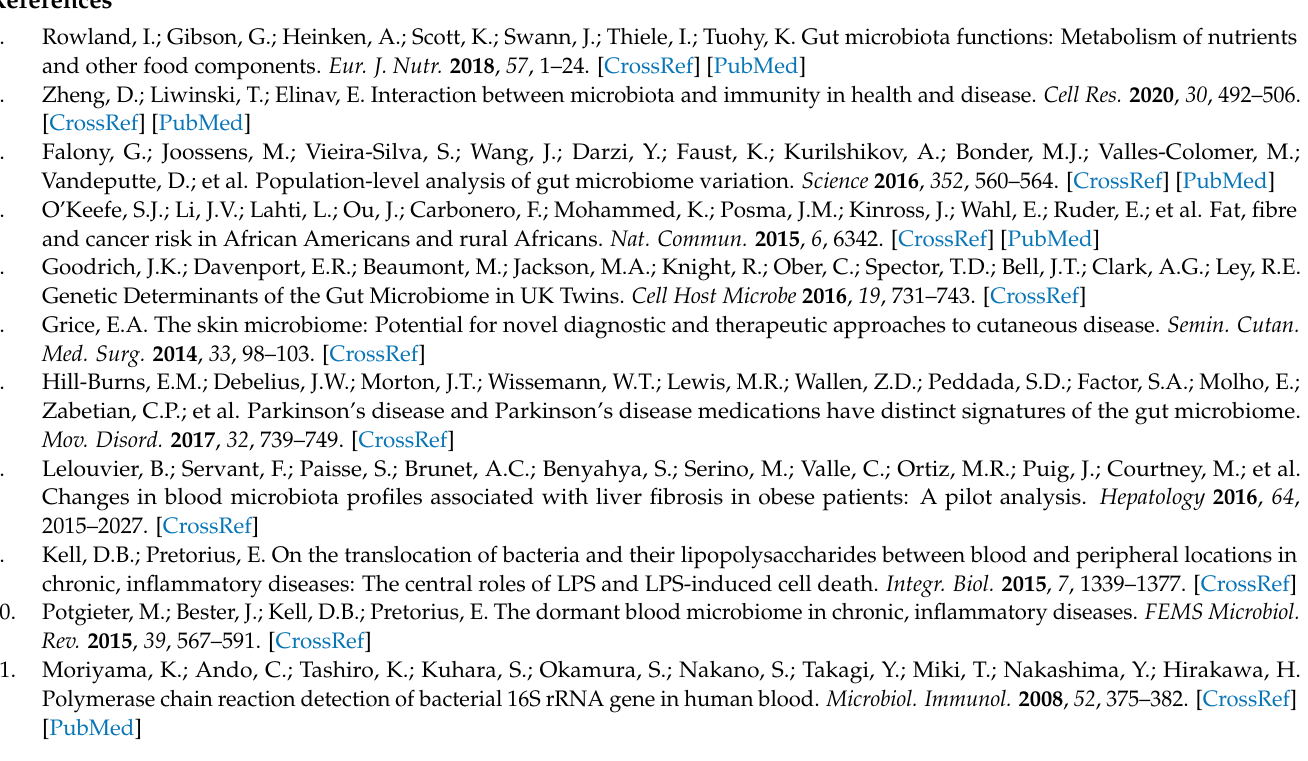
Table S1: Alignment statistics; Table S2: Association between alpha diversity and each age group; Table S3: MaAsLin analysis for association between age-related groups and blood microbiota compo- sition at class